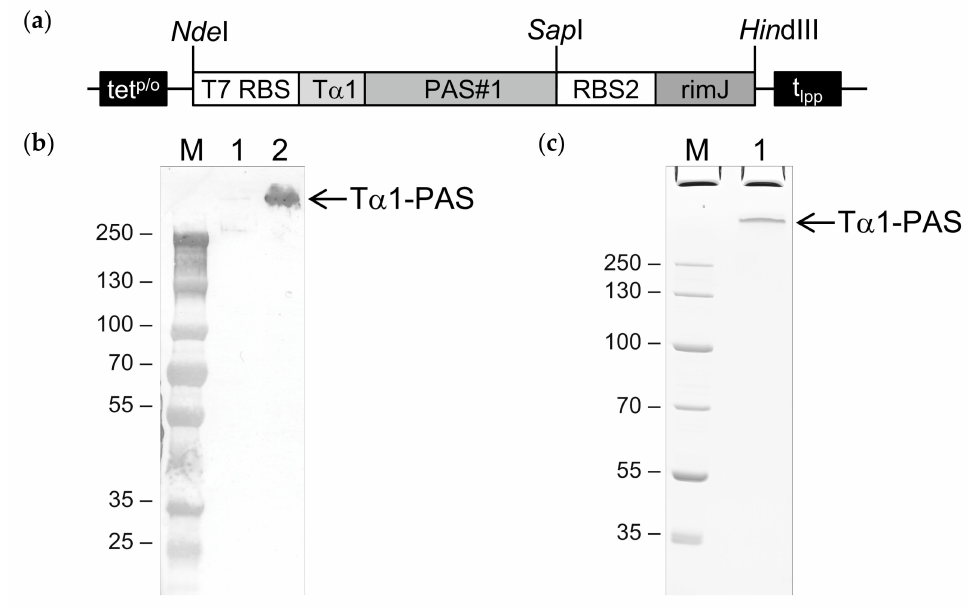
Figure 1. Bacterial production of N-terminally acetylated T α 1-PAS. ( a ) Expression vector for T α 1-PAS and the N- acetyltransferase RimJ from a bicistronic operon under control of the inducible tet p/o . The gene cassette cloned on pASK75 comprises the T7 phage ribosome binding site (T7 RBS) followed by the coding sequence for human T α 1 fused to a 601-residue PAS#1 sequence, the second RBS, the coding sequence for RimJ, and the lipoprotein terminator (t lpp ). ( b ) Western blot analysis after 4–12% SDS–PAGE of T α 1-PAS in the E. coli whole cell lysate using an antibody directed against the PAS#1 sequence. M, protein size standard; lane 1, whole cell extract before induction; lane 2, whole cell extract 15 h after induction. ( c ) 10% SDS-PAGE of purified T α 1-PAS. M, protein size standard; lane 1, T α 1-PAS after ammonium